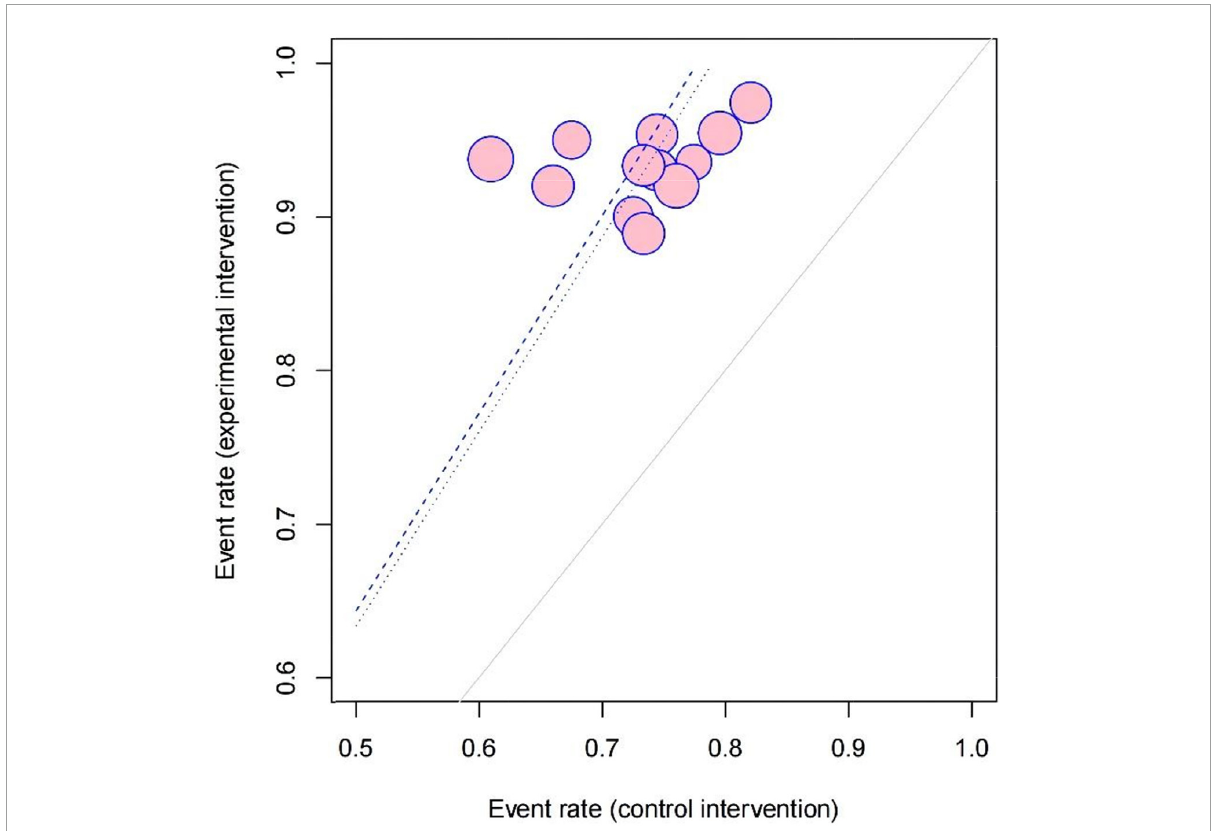
FIGURE4 Labbe plot of evaluating the source of heterogeneity and comparing the risks stemming from the clinical effectiveness between the intervention group and control group in 12 included